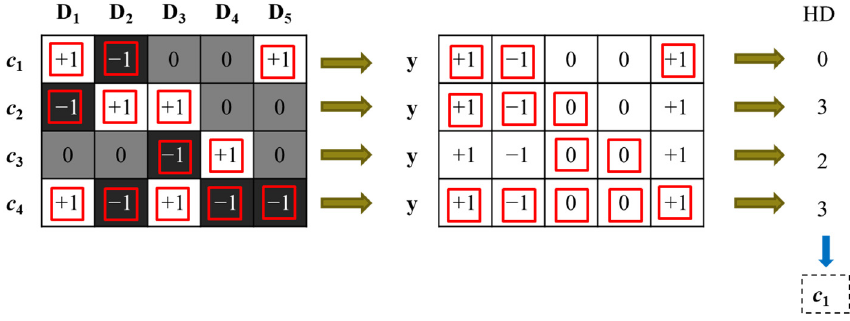
Figure 7. The output results of dichotomizers supervised by SM-ECOC-V2.